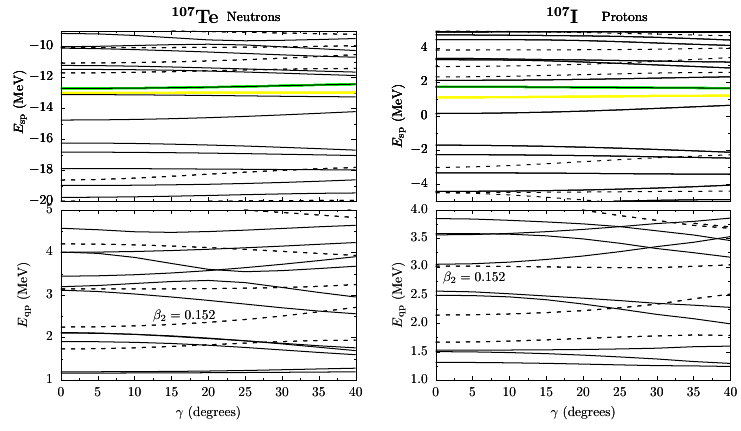
Figure 2. Rotational energies (panels a and b) and proton emission half-lives (panels c and d) at β 2 = 0 . 152 as a func- tion of γ for di ff erent set of parameters α and W of residual np interaction. Gray width in half-life represents the uncer- tainties due to the one in measured Q p